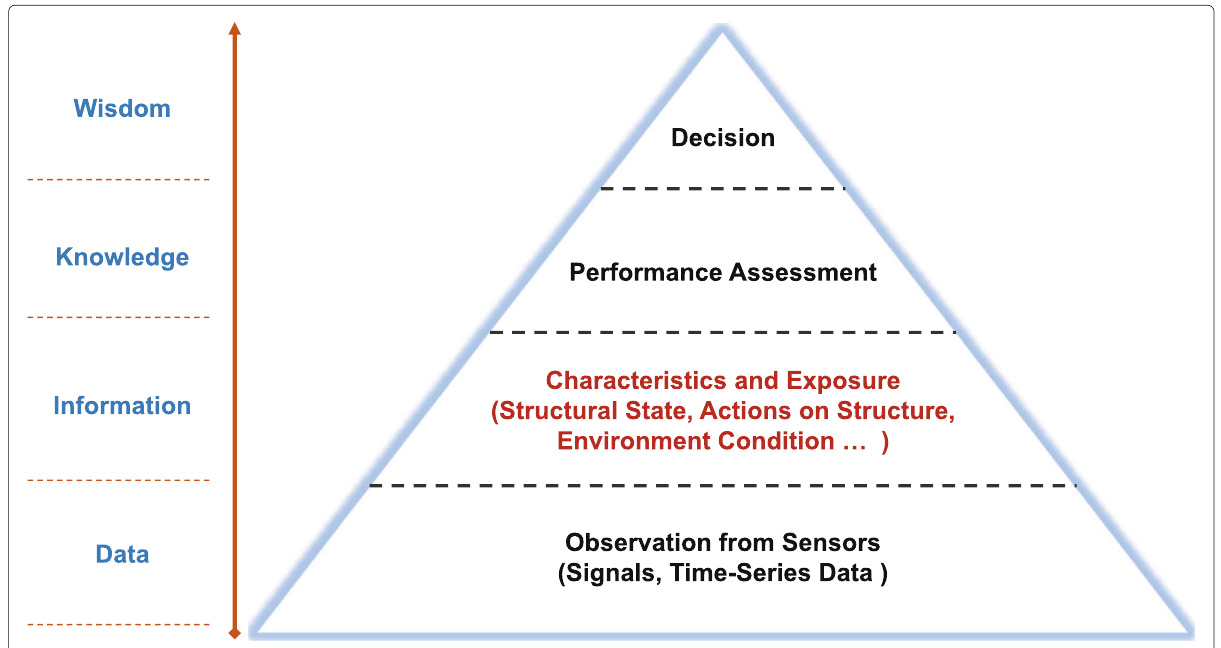
Fig. 1 The DIKW structure for the engineering decisions